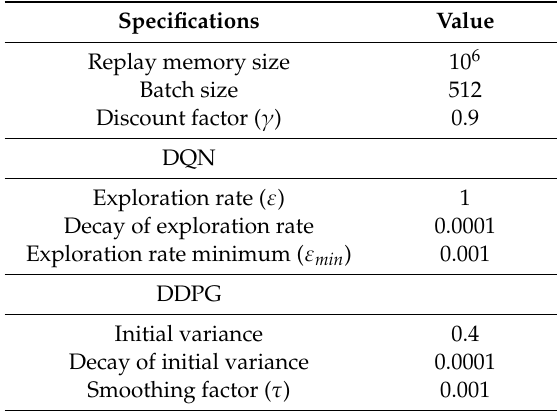
Table 2. Specifications of American Choice Solar ACS-335-M PV